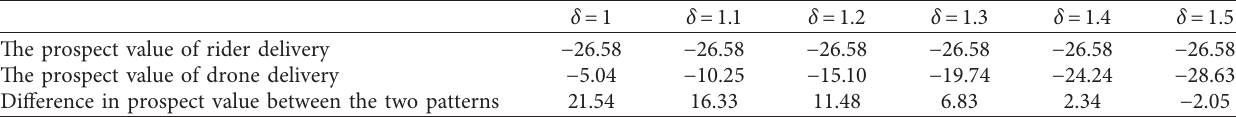
Table 10: The comparison of the prospect value of the two delivery patterns with different penalty coefficient when c � 1.1, t � 3, and L � 5.